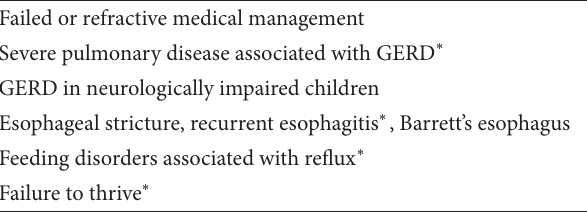
Table 3: Common indications for antireflux